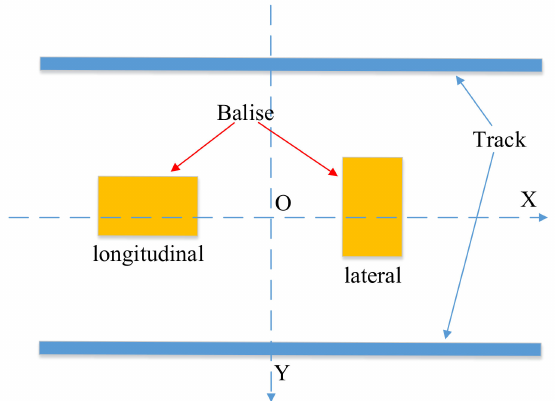
Figure 16. Schematic diagram of longitudinal and lateral balise.